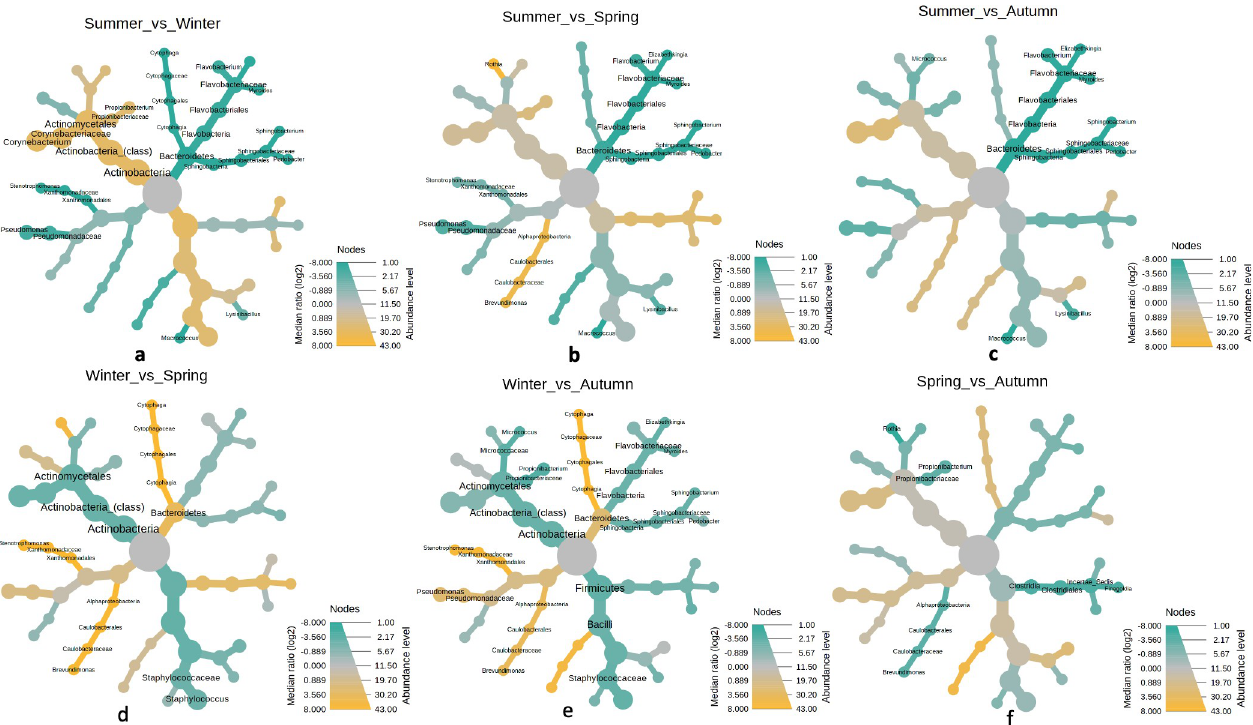
Fig 6. Pairwise comparison of differential abundances of bacterial taxa across the four seasons (a) summer vs winter (b) summer vs spring (c) summer vs autumn (d) winter vs spring (e) winter vs autumn and (f) spring vs autumn. Fungal communities. Only the significantly different taxonomic ranks are shown on the tree. The statistical parameter of Wilcoxon rank test (P < 0.05) was applied at median abundances to perform the differential tree analysis.